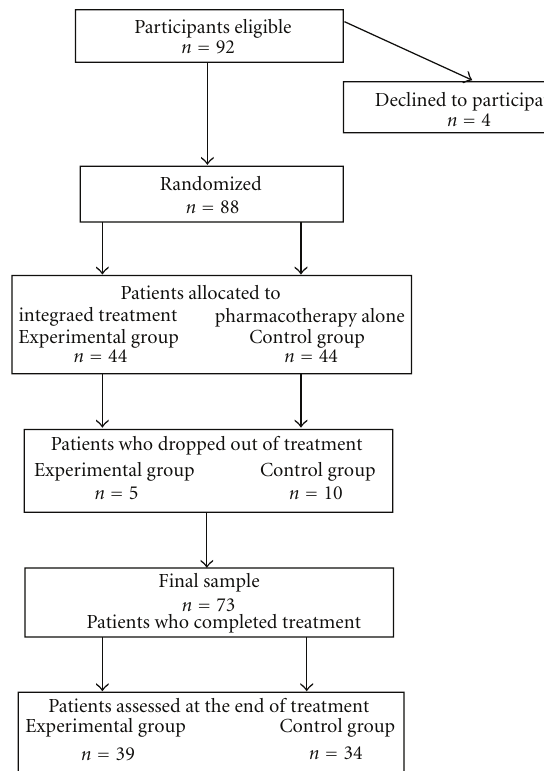
Figure 1: Participants flow